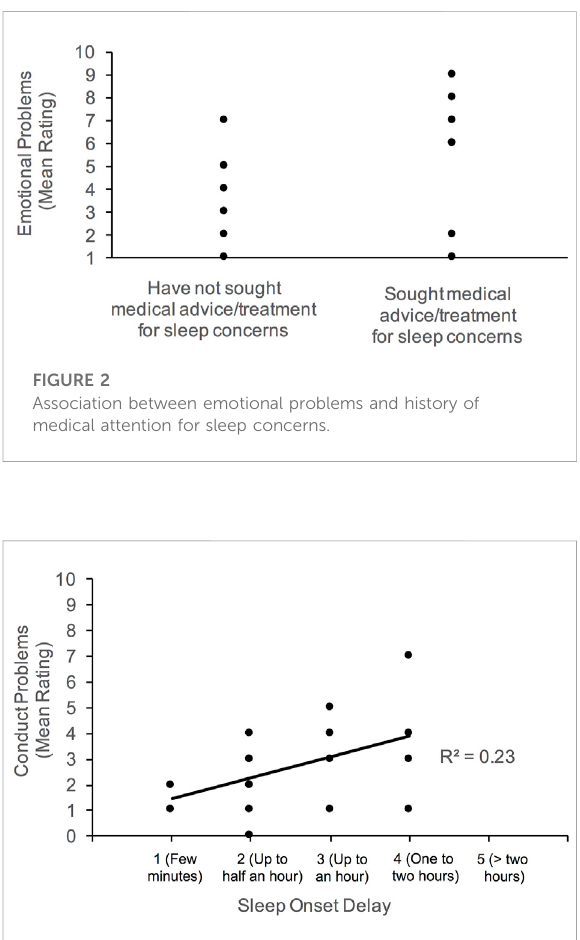
FIGURE 3 Association between conduct problems and sleep onset delay.